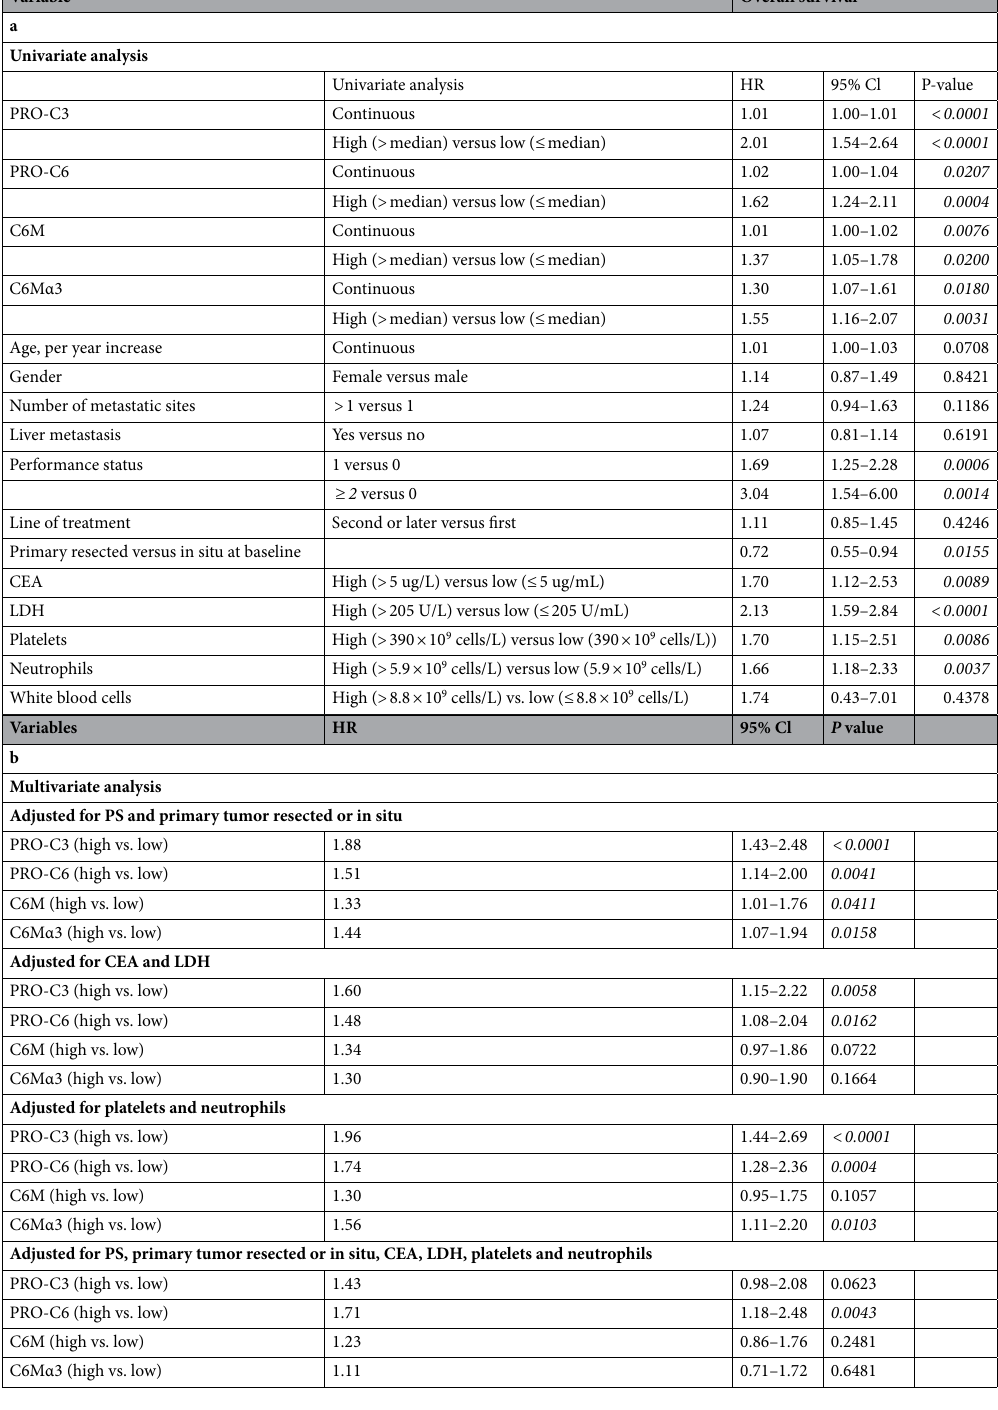
Table 2. Association between biomarker levels, clinical covariates and outcome for patients with mCRC. Uni- (a) and multivariate (b) cox proportional-hazards regression were used to calculate the hazard ratios (HR) with 95% Cl and p -values. A p-value of P < 0.05 was considered statistically significant (shown in italics). PS; performance status. CEA; baseline carcinoembryonic antigen. LDH; baseline lactate dehydrogenase. Biomarker high/low are based on